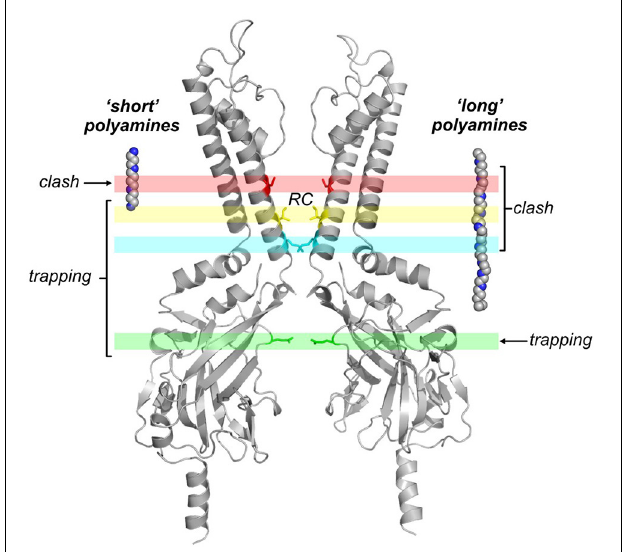
FIGURE 5 | Blocker trapping approaches highlight a deep polyamine binding site. This image summarizes the effects of MTS modification of pore-lining cysteines on kinetics of polyamine binding and unbinding, highlighted by two recent studies (Kurata et al., 2010, 2013). At positions deep in the pore (red band), the potency of all tested blockers is significantly reduced after modification with positively charged MTS reagents (“clash”). At intermediate positions (blue and yellow bands), short polyamines could be “trapped” in the inner cavity by modification just below the rectification controller position (inner cavity modifier), while blockade by long polyamine analogs is dramatically disrupted because the charged modifying reagent clashes with longer blockers. At the most superficial modification position tested (green band), both the long and short polyamines can be trapped. “RC” indicates the pore depth of the “rectification controller”